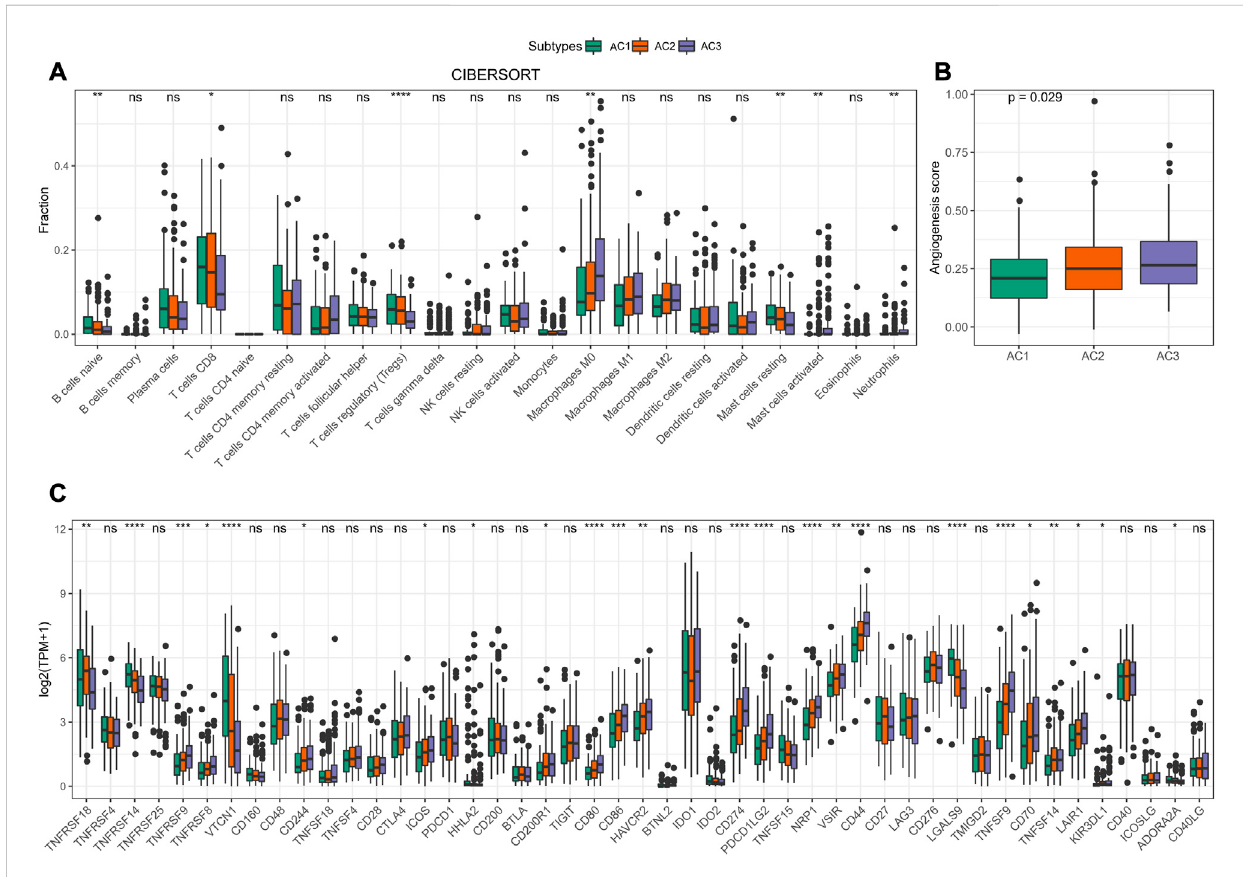
FIGURE 4 Features of TME in AC1-3 subtypes. (A) Distribution of immune cell scores estimated by CIBERSORT amongst three subtypes (B) Differences of Angiogenesis scores amongst three subtypes (C) Differences of immune checkpoint gene expression amongst three subtypes. ns p > 0.05; * p <